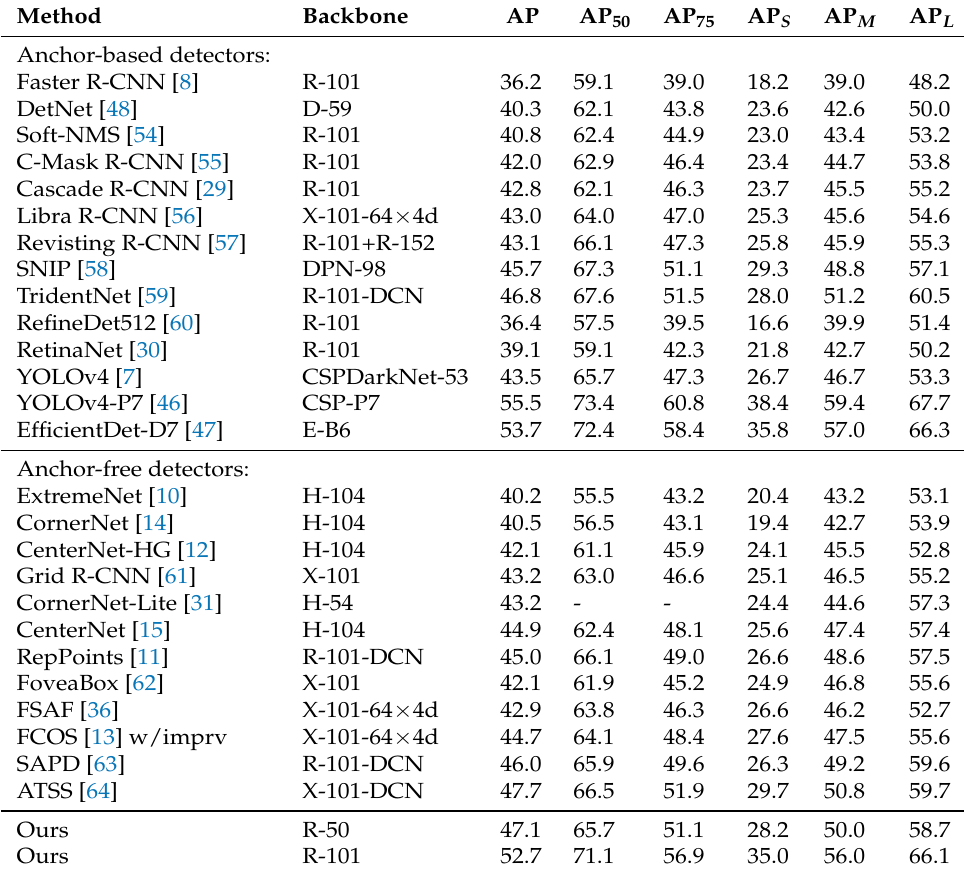
Table 5. Comparison with the state-of-the-art detectors on MS-COCO benchmark. The backbones include ResNet (R) [42], DetNet (D) [48], ResNeXt (X) [49], Dual Path Network (DPN) [50], Cross Stage Partial (CSP) [51], EfficientNet (E) [52], and Hourglass (H)